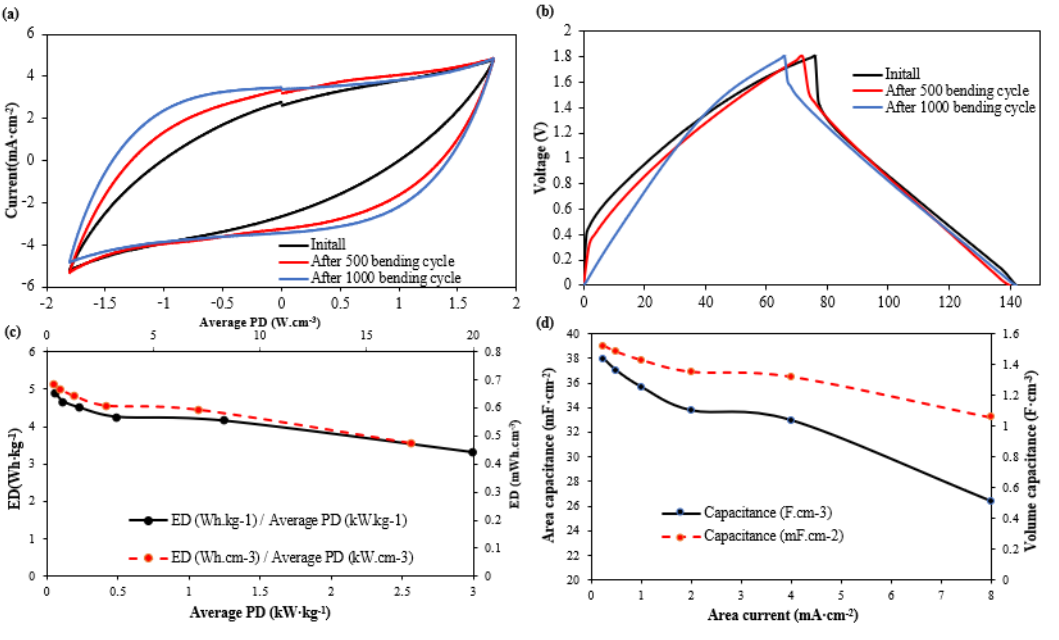
Figure 5. ( a ) CV and ( b ) GC result for single-layer textile supercapacitor based on PC3:7 before and after bending. ( c ) Energy density (ED) and average power density (PD) Ragone plot, ( d ) capacitance variation of single-layer textile supercapacitor based on PC 3:7 and extract from GC test with cycling currents are 0.25, 0.5, 1, 2, 4, 8 mA·cm −2 . All results are based on device thickness of 250 μm and carbon material loading of 3.56 mg·cm −2 .